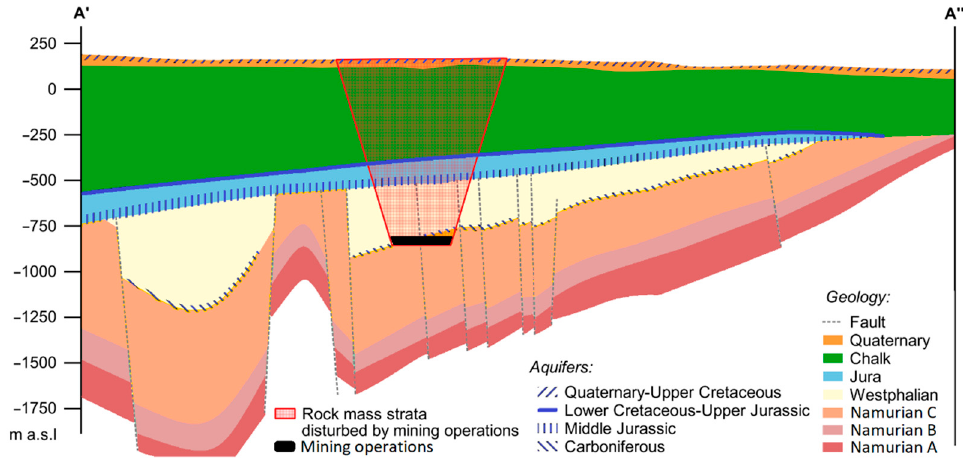
Figure 3. Schematic cross-section of geological strata and aquifer system in the area of interest, modified after [67,146]. The location of the cross-section is depicted in Figure 2. Source of data: the Polish Geological Institute-National Research Institute.